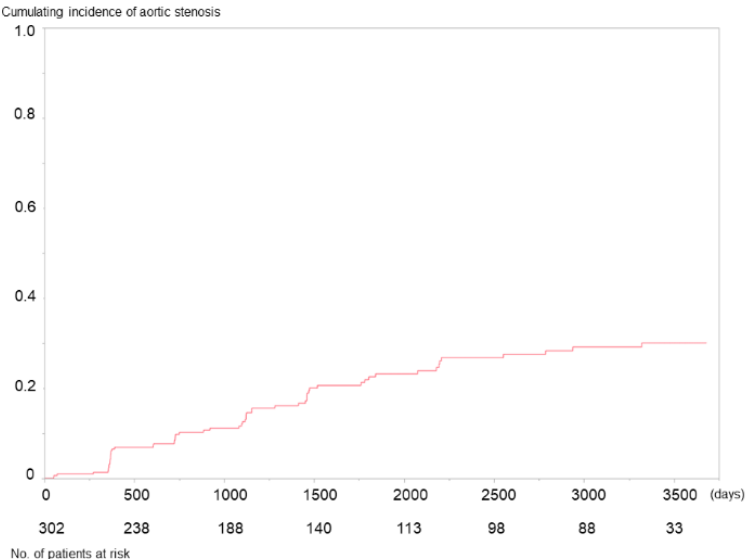
Figure 1. Patient flow.